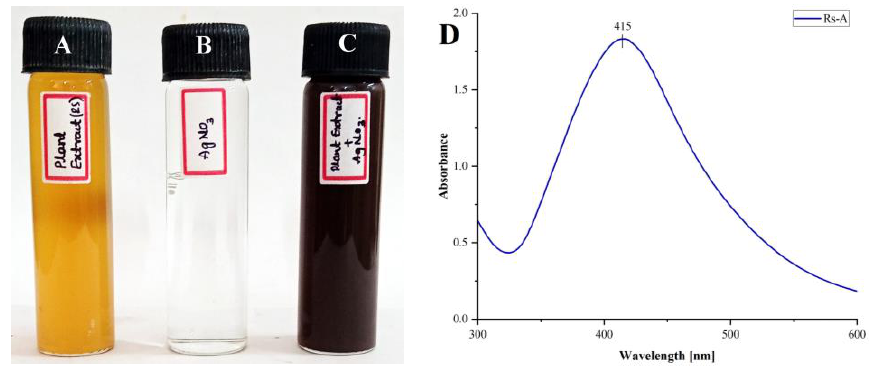
Figure 2. Change in color during the formation of AgNPs. ( A ) R. serrata flower bud extract, ( B ) silver nitrate solution, ( C ) reaction mixture (flower bud extract + AgNO 3 ), and ( D ) UV-Vis. absorption spectra of RsFb-AgNPs.